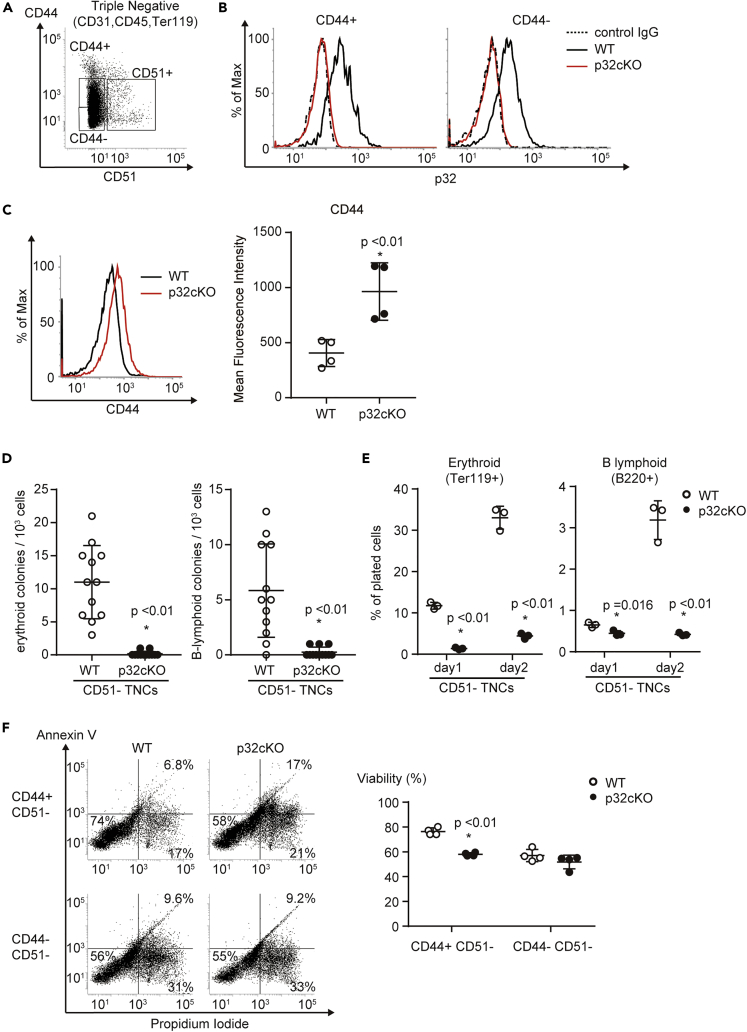
Mitoribosomes are Essential for CD45– Erythroid and B-Lymphoid Progenitor Differentiation(A and B) Representative flow cytometry plots of CD44 + CD51– and CD44– CD51– cells among CD31/CD45/Ter119 triple-negative cells (TNCs) in enzymatically digested bone marrow. Histograms of p32 (B) expression in CD44+ CD51– and CD44– CD51–cells among TNCs. The IgG isotype control is shown as a dotted line.(C) Histograms of CD44 expression in CD51– TNCs. Results are shown as the mean fluorescence intensity ±SD.(D) Sorted CD51– TNCs from WT and p32cKO mice were plated at low densities (1000 cells/well) in methylcellulose (Stem Cell Technologies, Cat#: M3334 [CFU-E] Cat#: 3630 [CFU pre-B + 25ng/mL SCF]). Erythroid and B-lymphoid colonies were enumerated at day 2 and day 5.(E) Quantification of Ter119+ (erythroid) and B220+ (B-lymphoid) cells that were differentiated from sorted CD51– TNCs of WT and p32cKO mice seeded in liquid culture with cytokines (stem cell factor, IL-3, IL-6, erythropoietin, and thrombopoietin) under normoxia for 48 hr. Cell numbers in each population were normalized as the percentage of total cells plated per well (% of cells plated).(F) FACS analysis of cell death in CD44+ CD51– TNCs, and CD44– CD51– TNCs (left). The rates of the population of Annexin V–/Propidium Iodide– are indicated (right). In (C–F) data are shown as means ± SD. ∗p < 0.05 versus WT mice. Data are representative at least three (A–F) independent experiments.See also Figures S4.